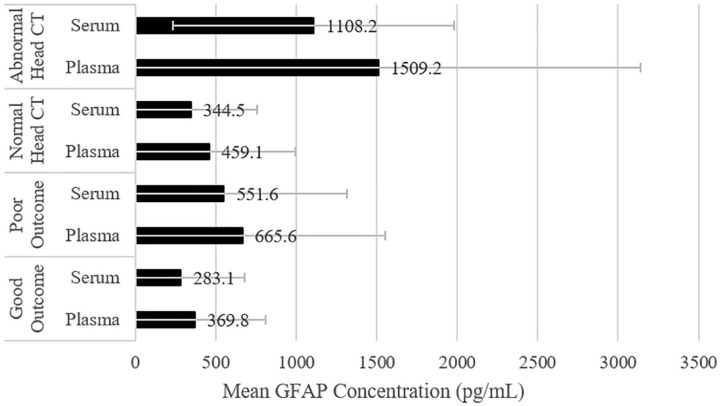
Comparing plasma and serum GFAP levels among subgroups. The mean values are displayed, and the error bars represent one standard deviation. CT, Computed Tomography; GFAP, Glial Fibrillary Acidic Protein.